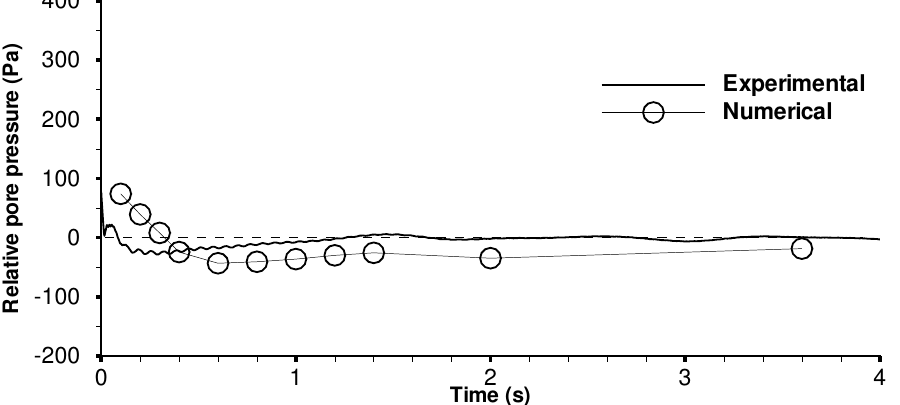
Figure 13. Relative pore water pressure at point P 1 during the collapse process of an initially dense packing granular